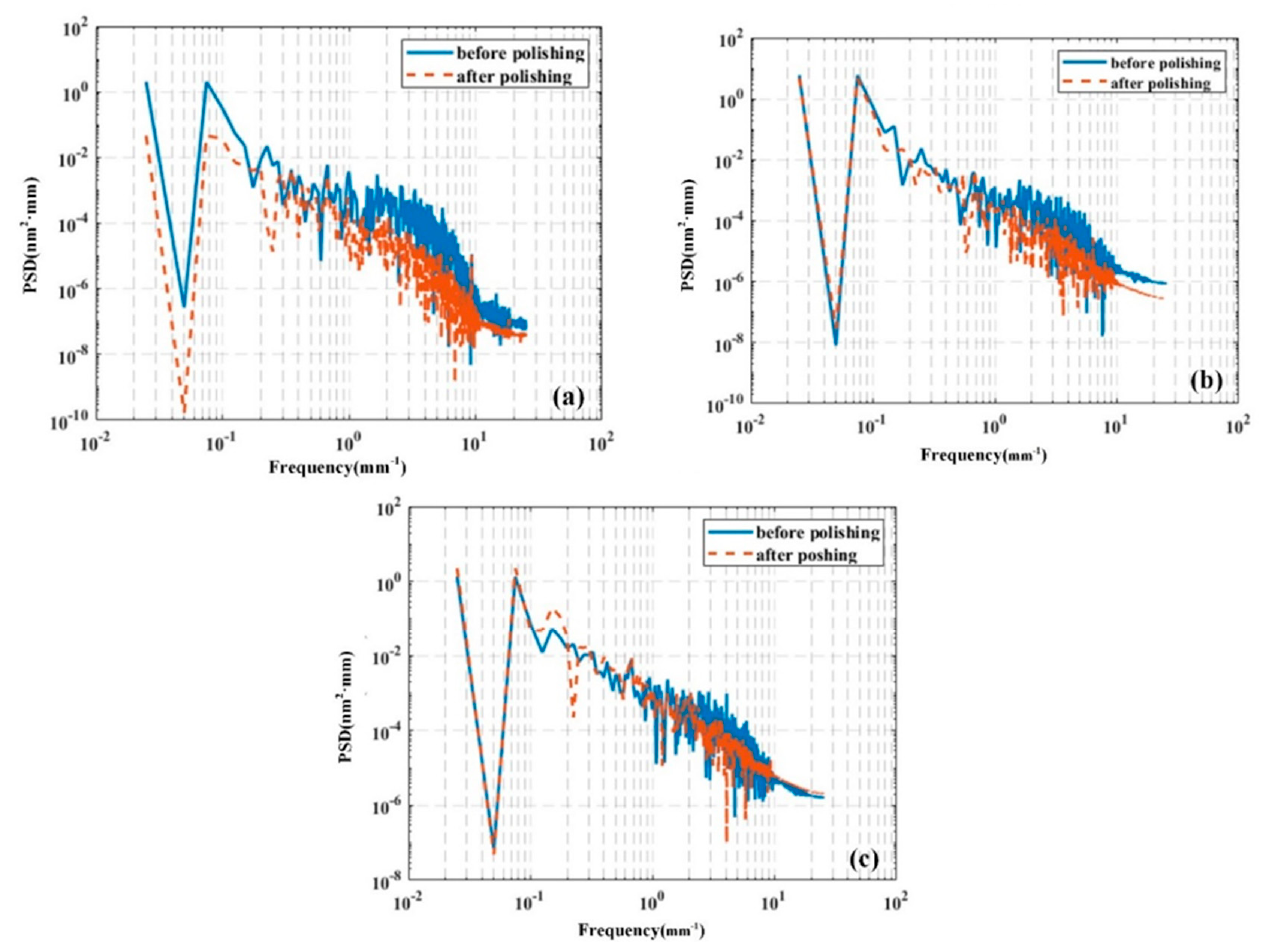
Figure 9. PSD curves for the normal errors of ( a ) 0°, ( b ) 0.5°, and ( c ) 1°.